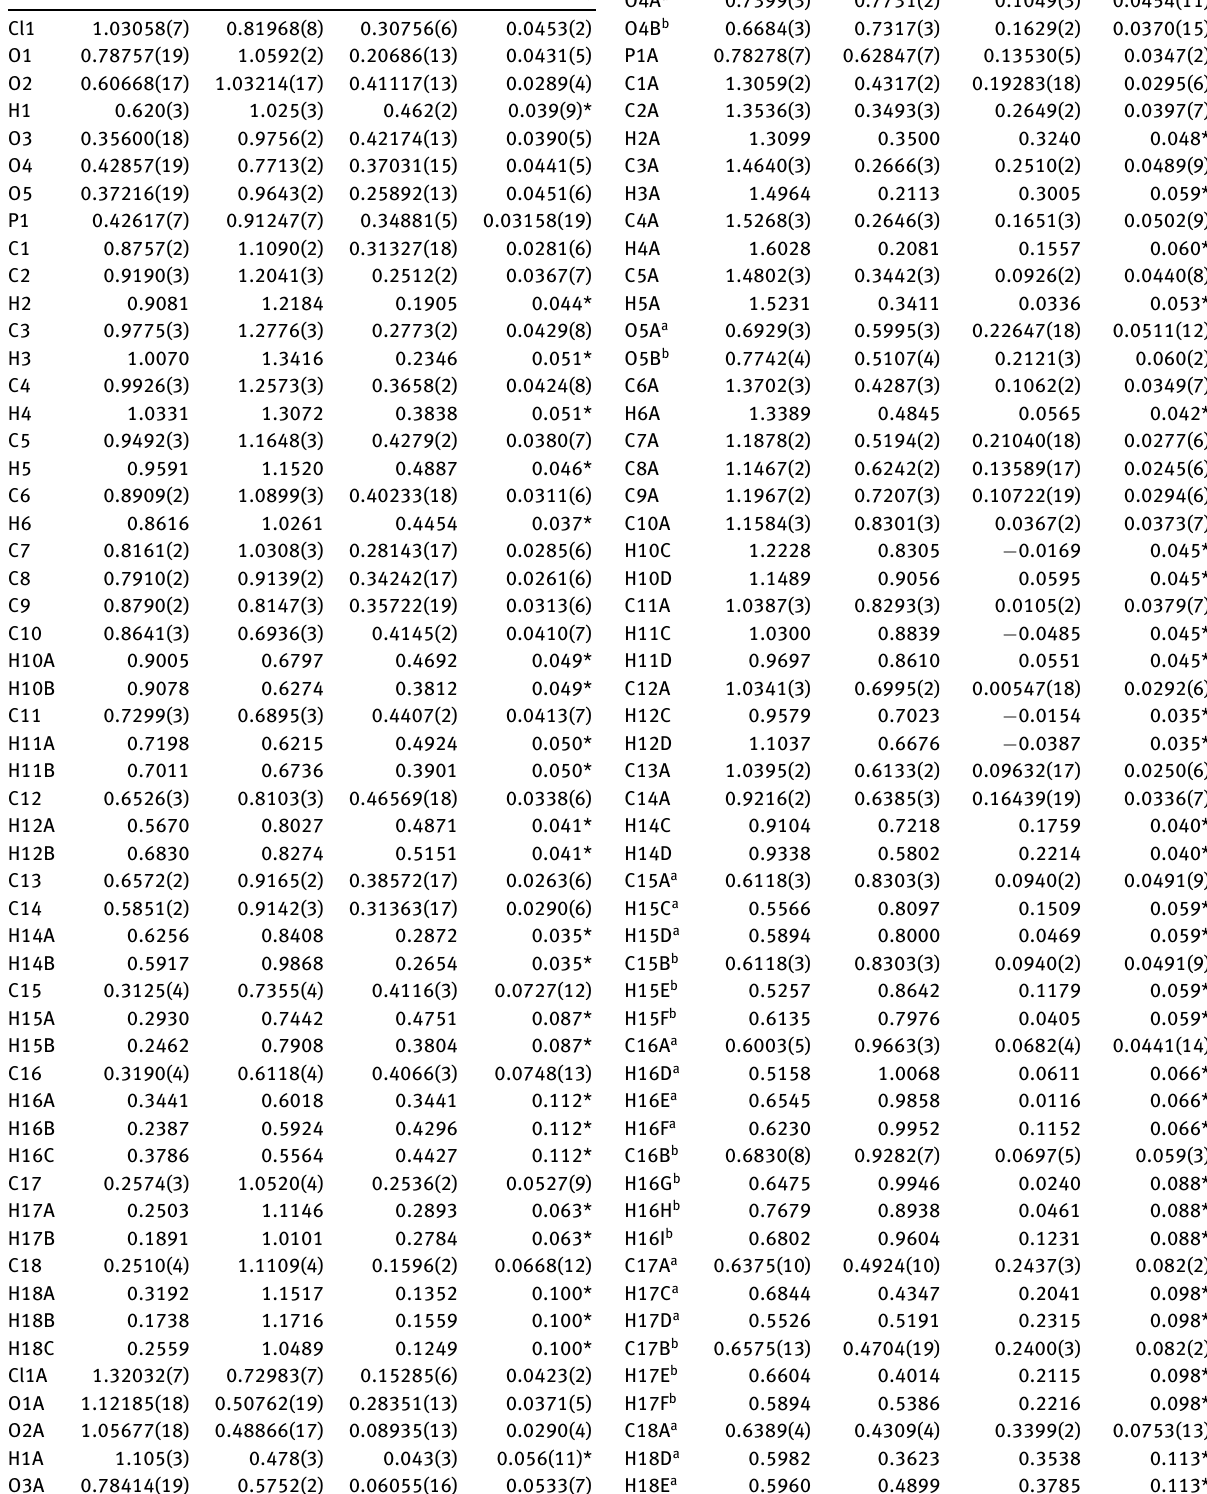
Table 2: Fractional atomic coordinates and isotropic or